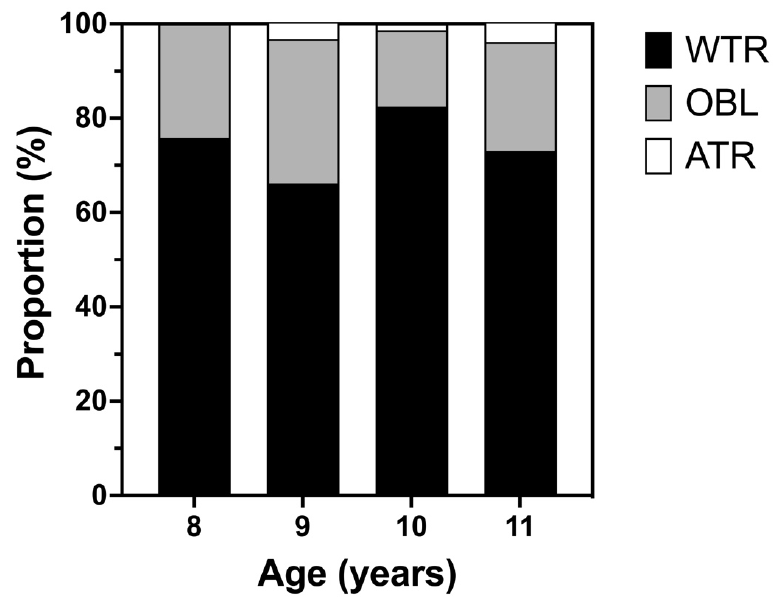
Figure 1. Proportions of With-The-Rule (WTR), Against-The-Rule (ATR), and Oblique (OBL) astigmatism across ages.